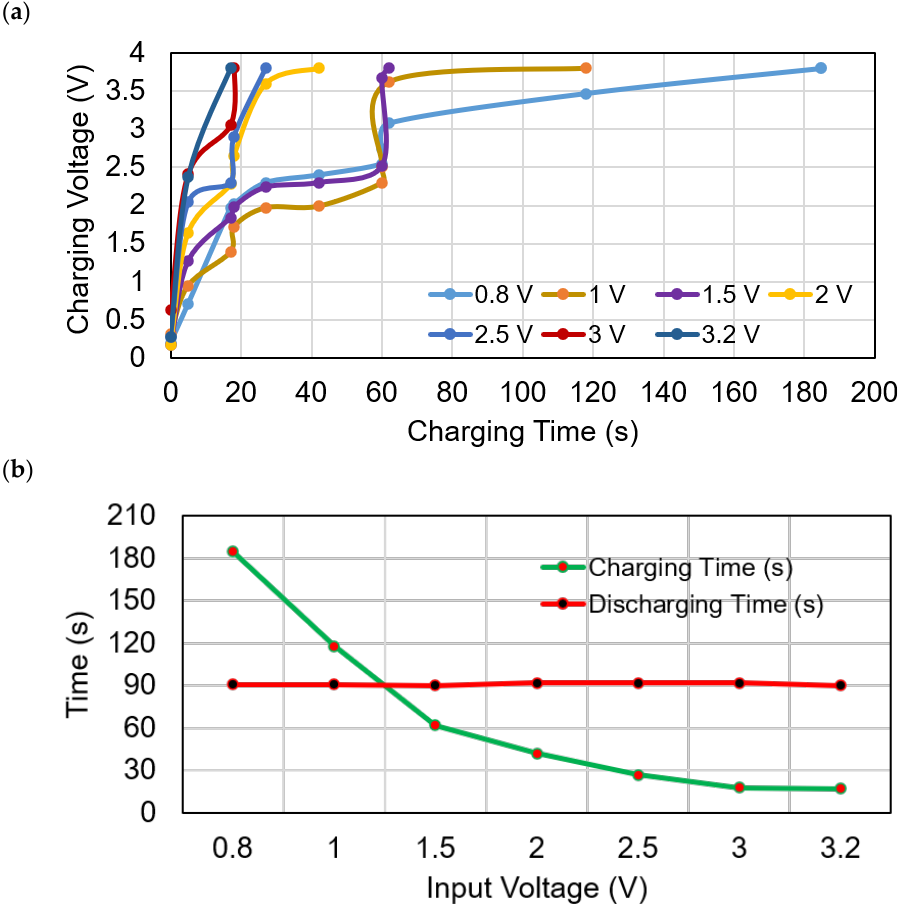
Figure 13. ( a ) charging voltages and the respective times in different input voltages; ( b ) SC charging and discharging voltage versus time.